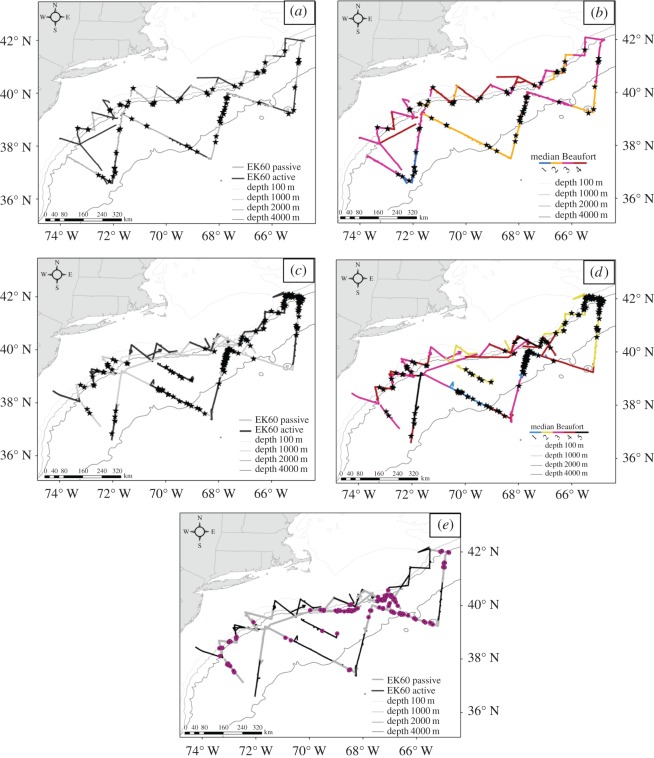
Map of tracklines surveyed in 2011 (a,b) and 2013 (c,d,e), by EK60 status and Beaufort sea state. Visual sightings of beaked whales are represented by black stars (a--d); acoustic BEAK detections are represented by purple circles (e). Note that the statistical analyses combined sea states into low (Beaufort 1–2) and high (Beaufort 3+).